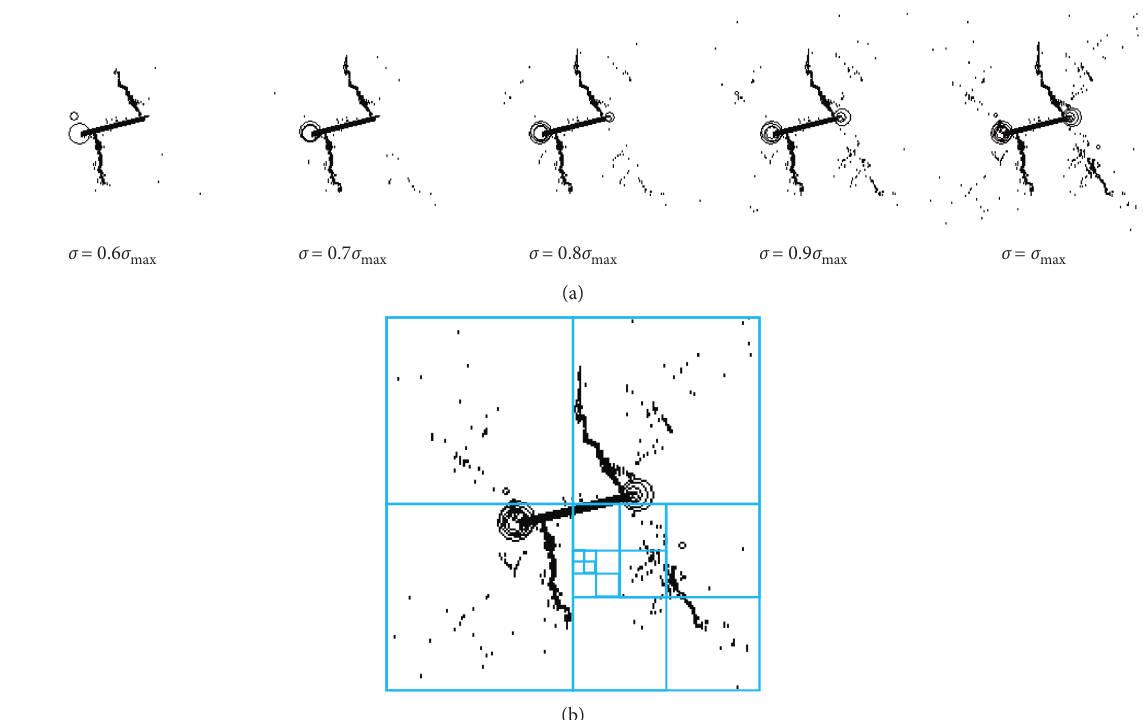
Figure 9: Schematic diagram of calculation of fractal dimension of concrete material fracture evolution.